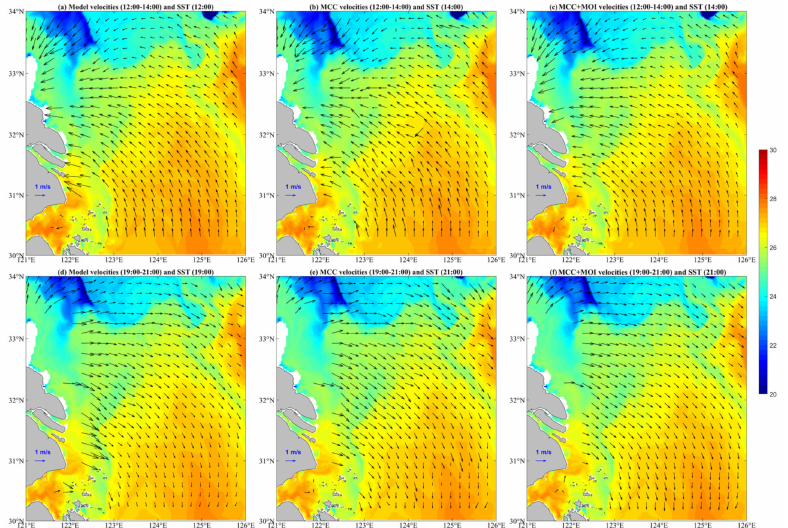
Figure 3. The averaged velocity fields from model (left), MCC (middle), and MCC+MOI (right) for